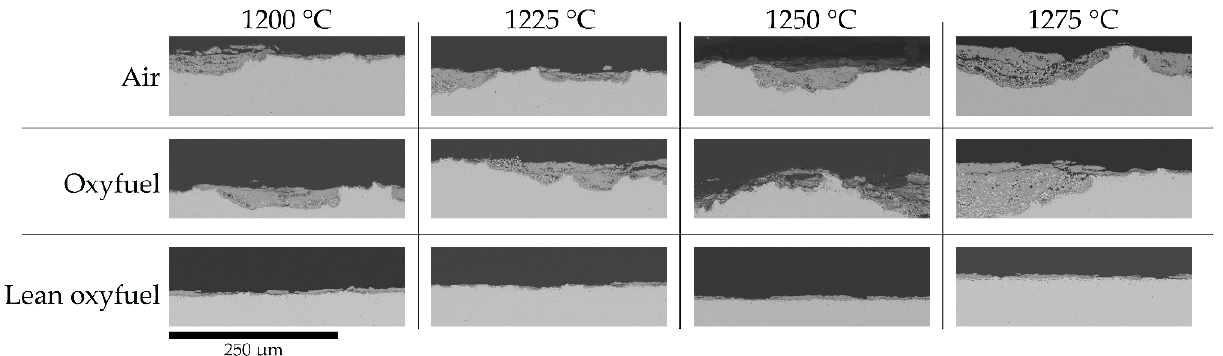
Figure 3. Overview back-scattered electron (BSE) FESEM images from the samples. Shown are the metal substrate (light grey), the attached oxide layer (medium grey), and mounting epoxy (black). Scale bar is 250 μ m.